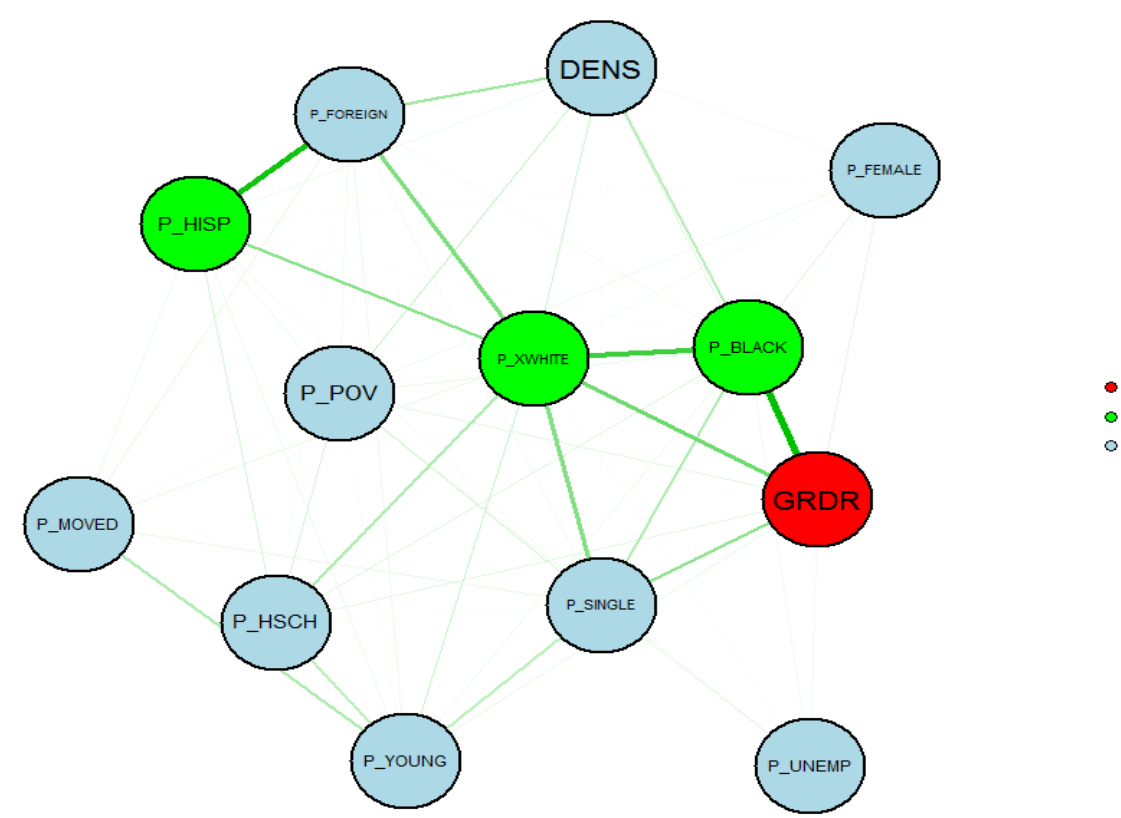
Figure 2. Strength of non-linear associations among both demographic and SDH variables and the gonorrhea diagnosis rate. GRDR represents gonorrhea diagnosis rate and R/E represents the race/ ethnicity